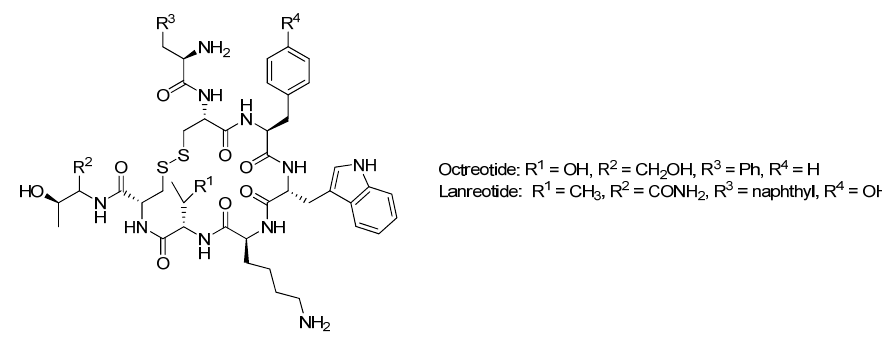
Figure 5. Macrocyclic agents related to pituitary